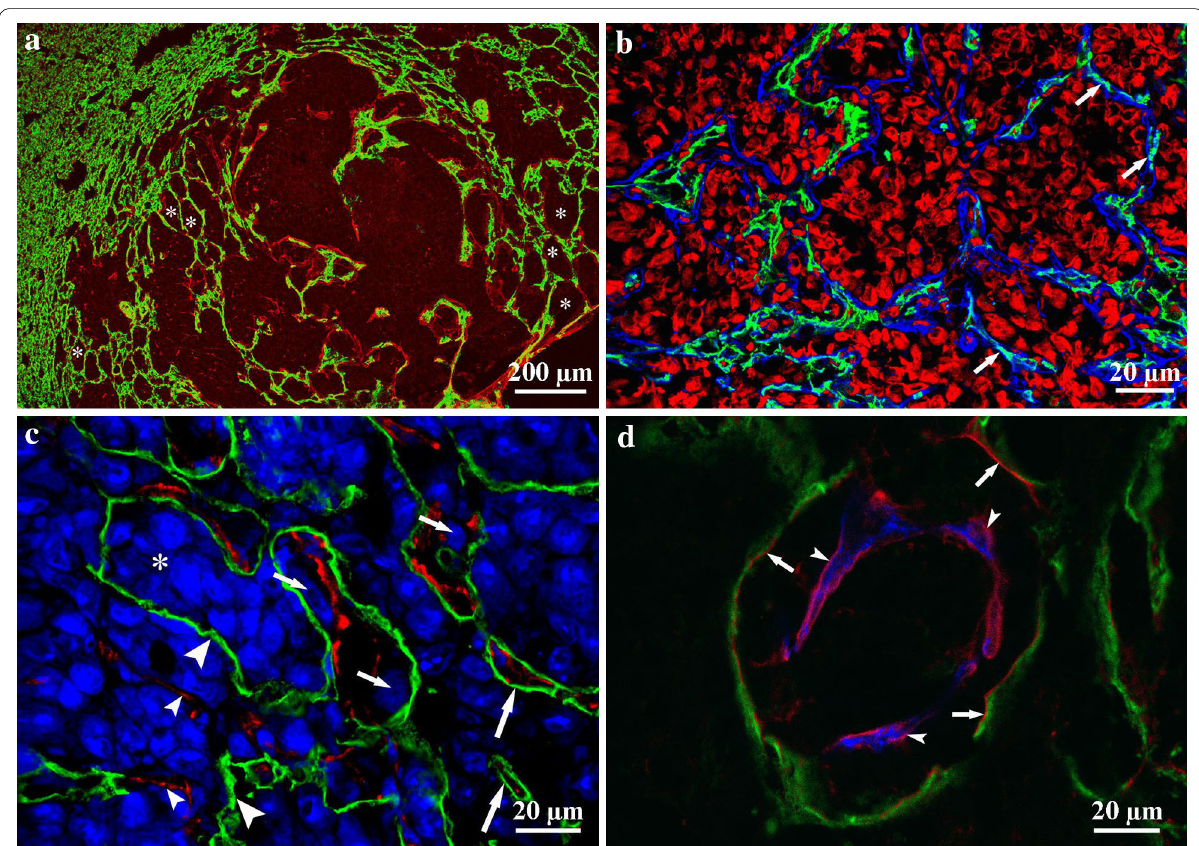
Fig. 3 Vascularization of lung metastases. a Frozen section of a colorectal carcinoma metastasis in the lung. CD31 (vessels, green ) and laminin (basement membrane, red ) show that normal lung parenchyma is present ( left side ) next to the tumor tissue ( right side ). Tumor tissue is recognizable ( pale-red ) because of the laminin deposited by tumor cells. Alveoli are filled by tumor cells to different extents ( asterisks ). Scale bar 200 µm. b The peripheral region of a lung metastasis. Alveolar structure is preserved, and capillaries (CD31, green ) are located within the alveolar walls (laminin, blue ; arrows ). The alveolar spaces are filled by tumor cells (propidium iodide, red ). Scale bar 20 µm. c Lung metastasis of B16 melanoma cells. Tumor cells are stained by TOTO‑3 ( blue ). Tumor cells ( small arrows ) can be observed between pneumocytes (podoplanin, green ) and the vessel wall (CD31, red ). The alveolar structure is mostly disintegrated; however, intact alveolar walls still can be observed ( large arrows ). Asterisk shows the original alveolar lumen filled by tumor cells. Denuded vessels ( small arrowheads ) and vessel‑free pneumocytes ( large arrowheads ) are located within the tumor tissue. Scale bar 20 µm. d High‑power confocal image of a lung metastasis. This figure shows that both the detached pneumocytes (podopla‑ nin, green ; arrows ) and the vessel (CD31, blue ; arrowheads ) have their own basement membrane (laminin, red ), and tumor cells are located between them. Scale bar 20